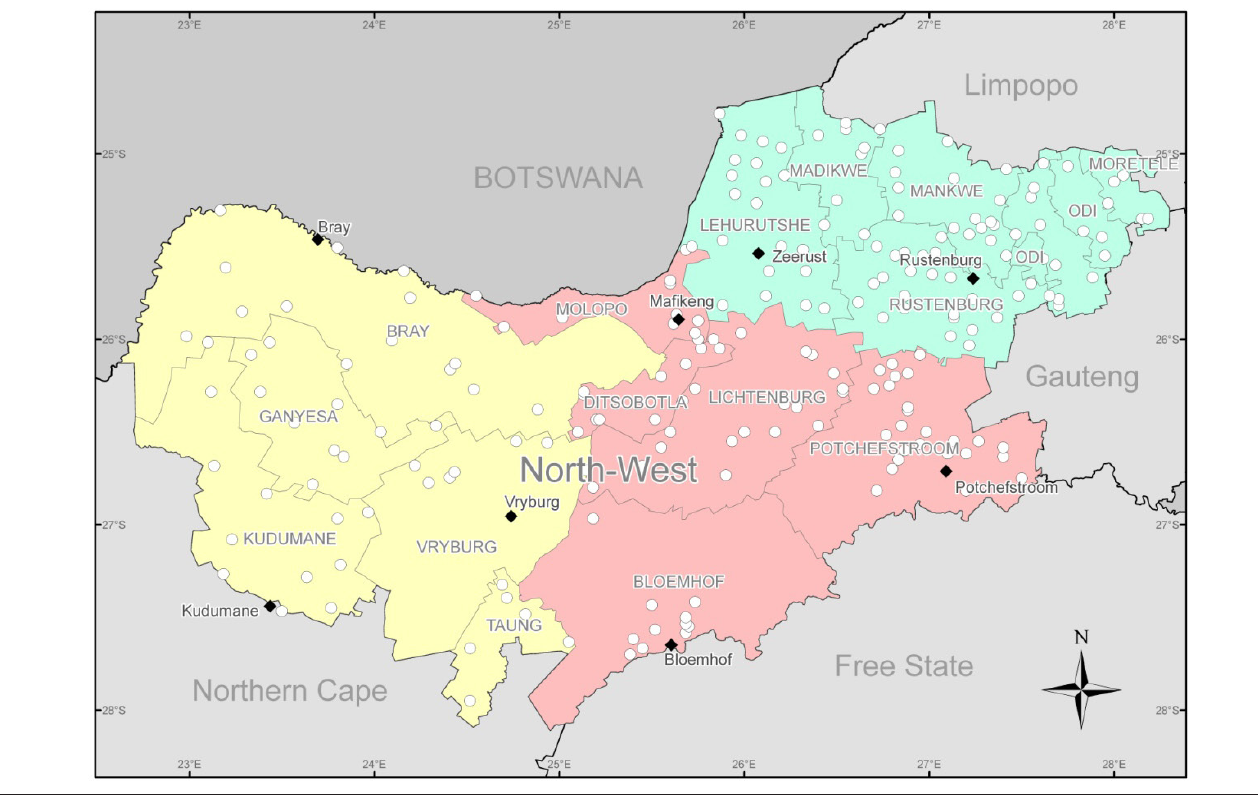
FIGURE 2: State veterinarian areas in the north-eastern, central and western regions that served as collection sites for the three-phase tick collection survey in the North West province, South